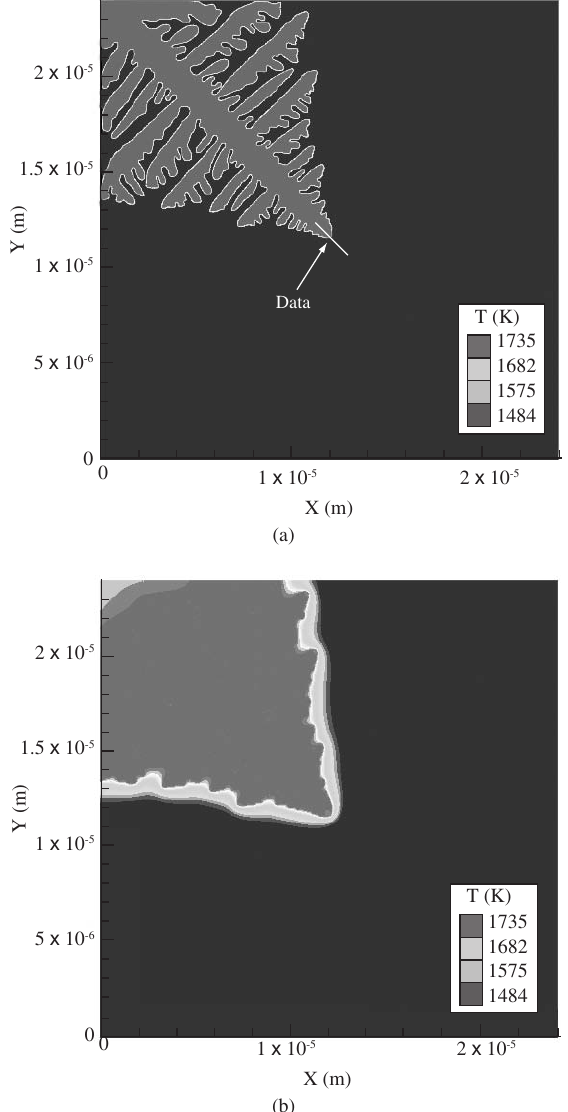
Figure 6. a) Phase and b) temperature fields in dendritic growth.